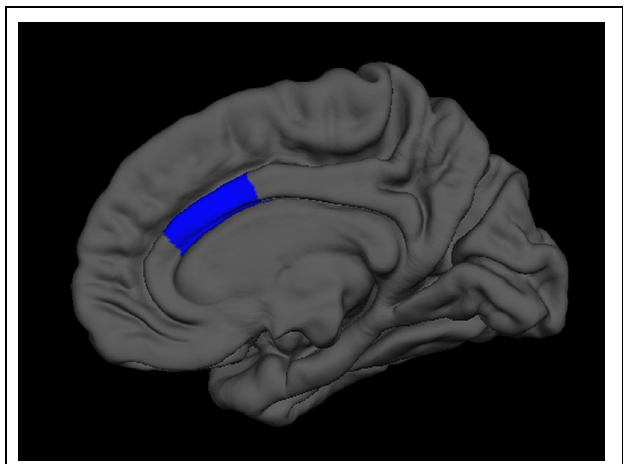
FIGURE 4 | FreeSurfer rendering of the right hemisphere pial surface with the caudal anterior cingulate indicated in blue, showing decreased cortical thickness in this region associated with increased fluency on the Foresight task.